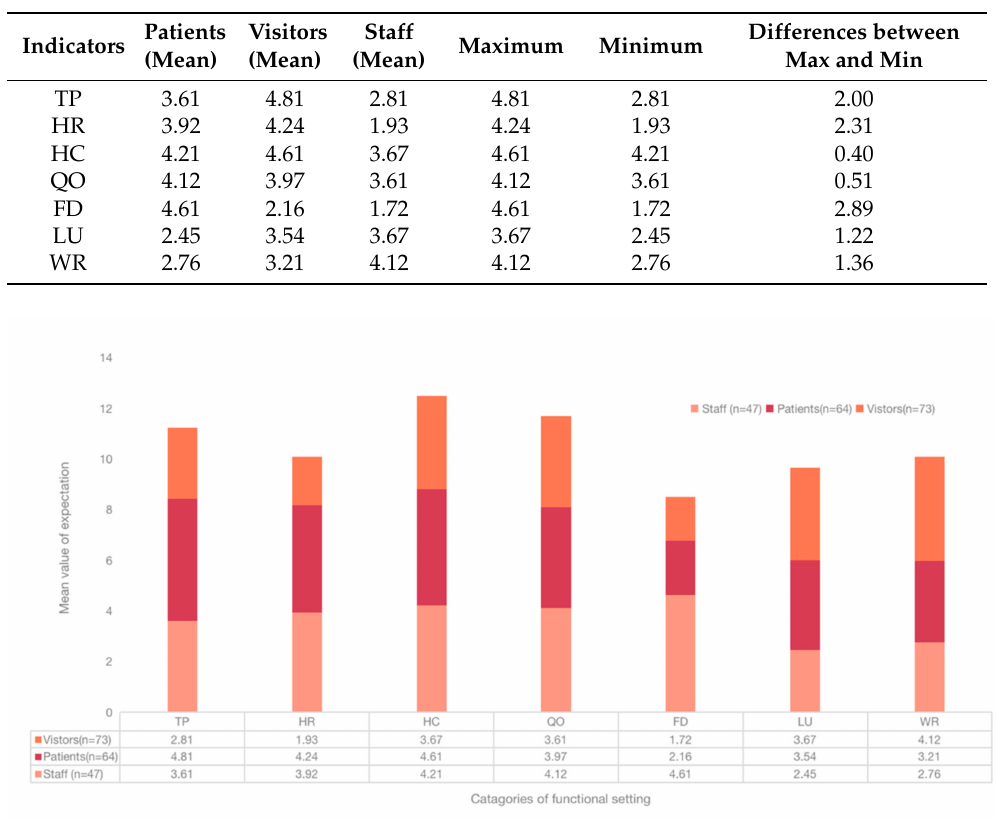
Table 5. Differences on the expectations of the functional setting by different groups.